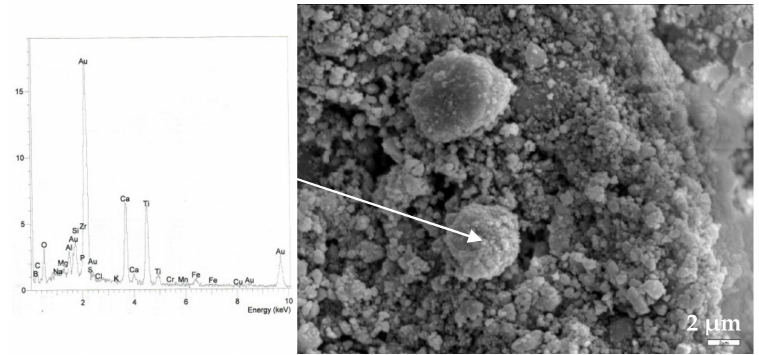
Figure 6. SEM image (4000 × ) and energy graph of coated surface S20, after annealing at 600 ◦ C for 1